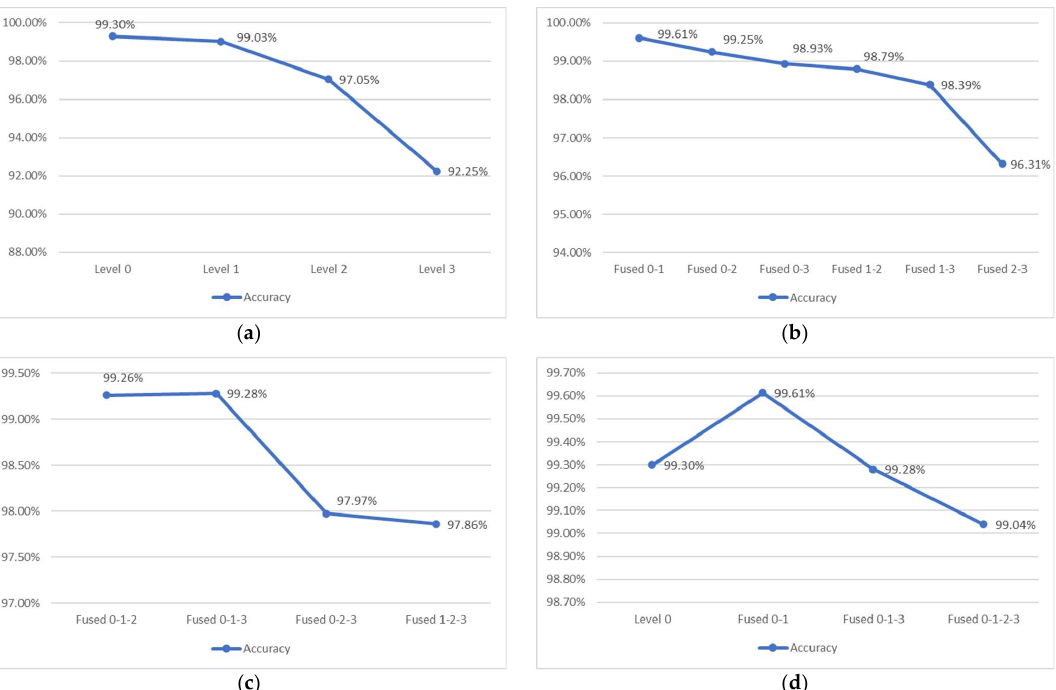
Figure 10. The accuracies distribution of individual and fused networks based on NEU dataset. ( a ) Individual network ( b ). Fused two networks. ( c ) Fused three networks. ( d ) Greatest performance of individual and fused networks.